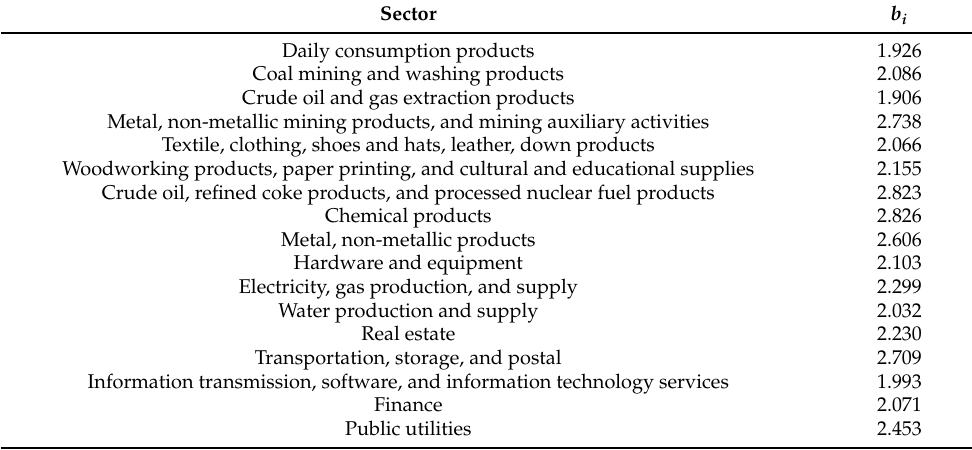
Table A4. The results of calibration of b i .